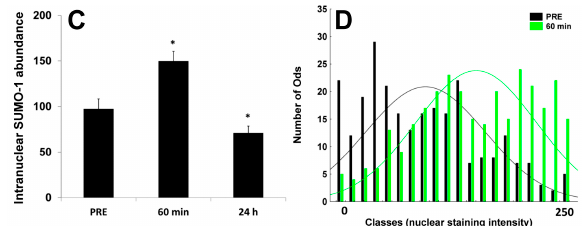
Figure 5. Representative immunofluorescence staining of SUMO-1 and lamin-A in myonuclei (SUMO-1 labelled with Alexa 555, Red, lamin-A labelled with Alexa 488, Green). Quantification of intranuclear SUMO-1 accumulation. ( A ) Representative images of nuclear membrane staining with lamin-A and intranuclear SUMO-1 localization within skeletal muscle myonuclei under resting conditions (PRE) and (Figure 5A, merge between lamin-A and SUMO-1, 400× magnification; Figure 5(A1–3) merge and Figure 5(A2–4) SUMO-1 signal from 1–3); ( B ) 60 min post RE. (Figure 5B, merge between lamin-A and SUMO-1, 400× magnification; Figure 5(B1–3) merge and Figure 5(B2–4) SUMO-1 signal from 1–3); ( C ) Quantification of intranuclear SUMO-1 localization within myonuclei at PRE, 60 min and 24 h post RE. (*) Significantly different from PRE values ( p < 0.01); ( D ) Histogram showing the frequency of analyzed myonuclei with increasing intranuclear SUMO-1 abundance at 60 min post RE (bright green bars) when compared to PRE (black bars) from left to right. (0 = almost no nuclear SUMO-1 abundance, 250 = almost entire intranuclear abundance.)